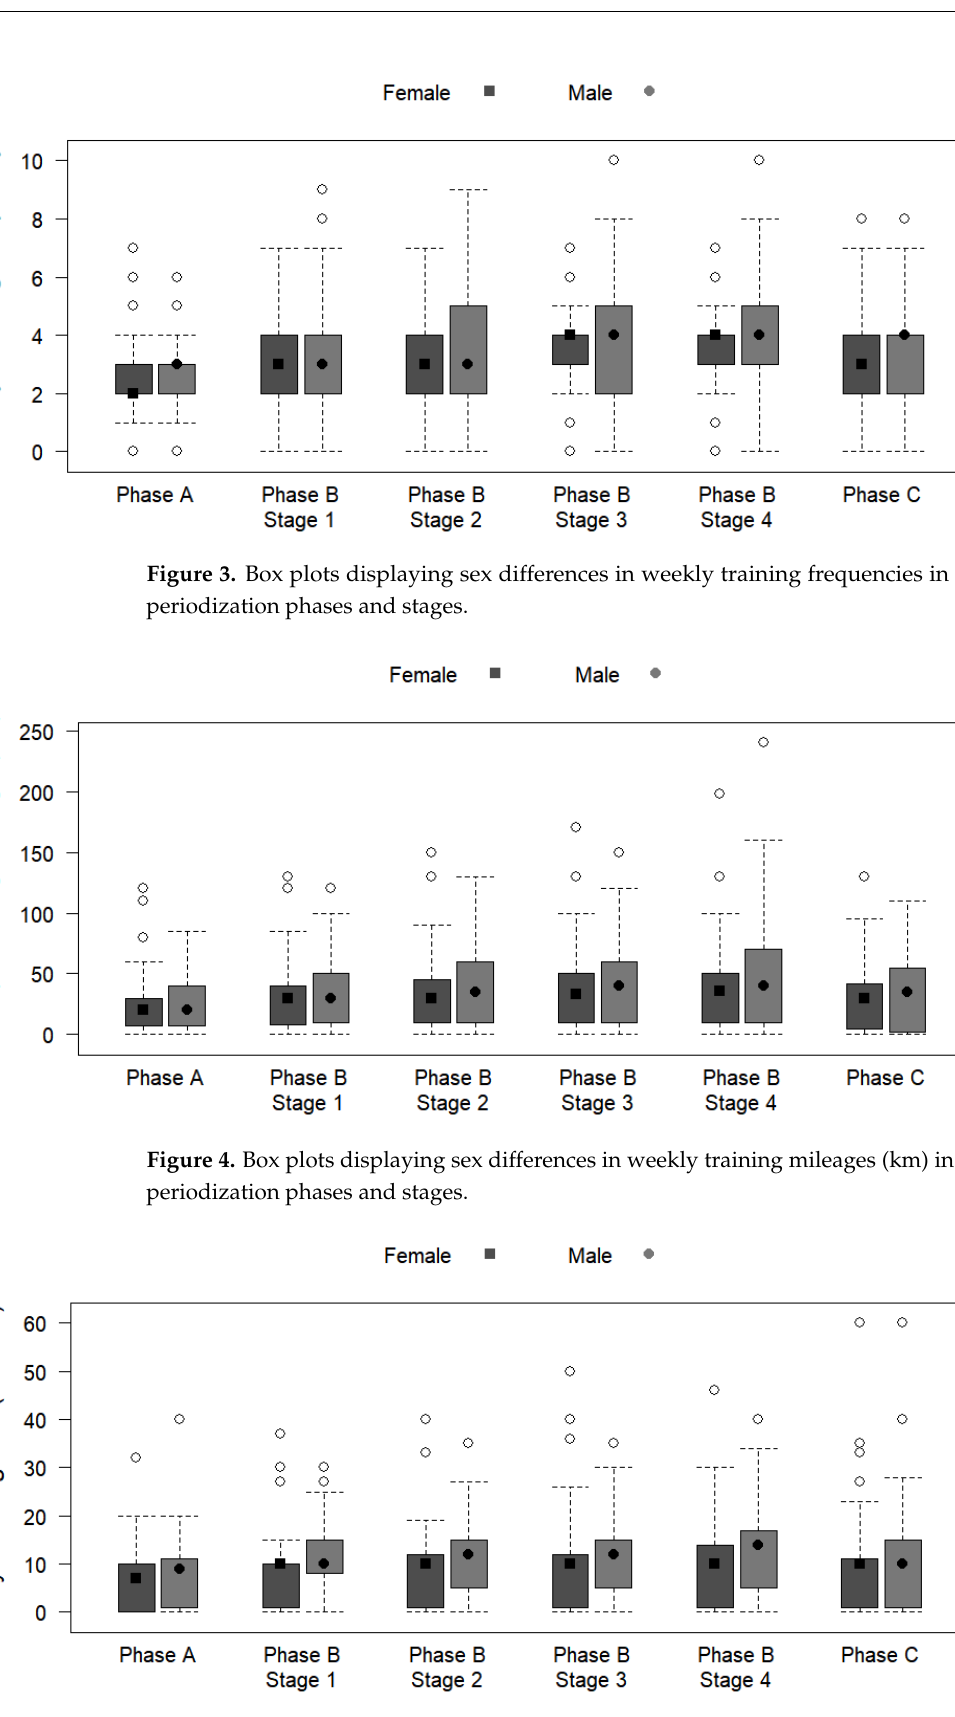
Figure 5. Box plots displaying sex differences in daily training unit (km/unit) in different training periodization phases and